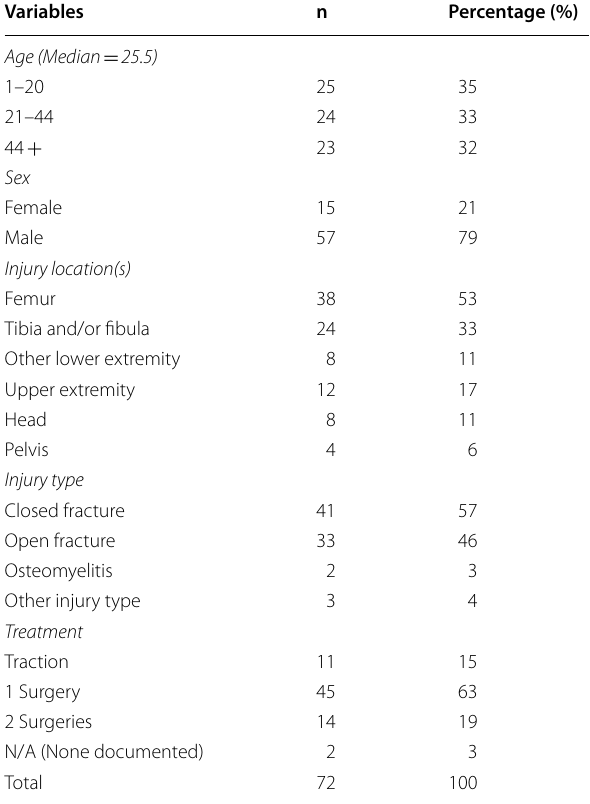
Table 2 Patient demographic information